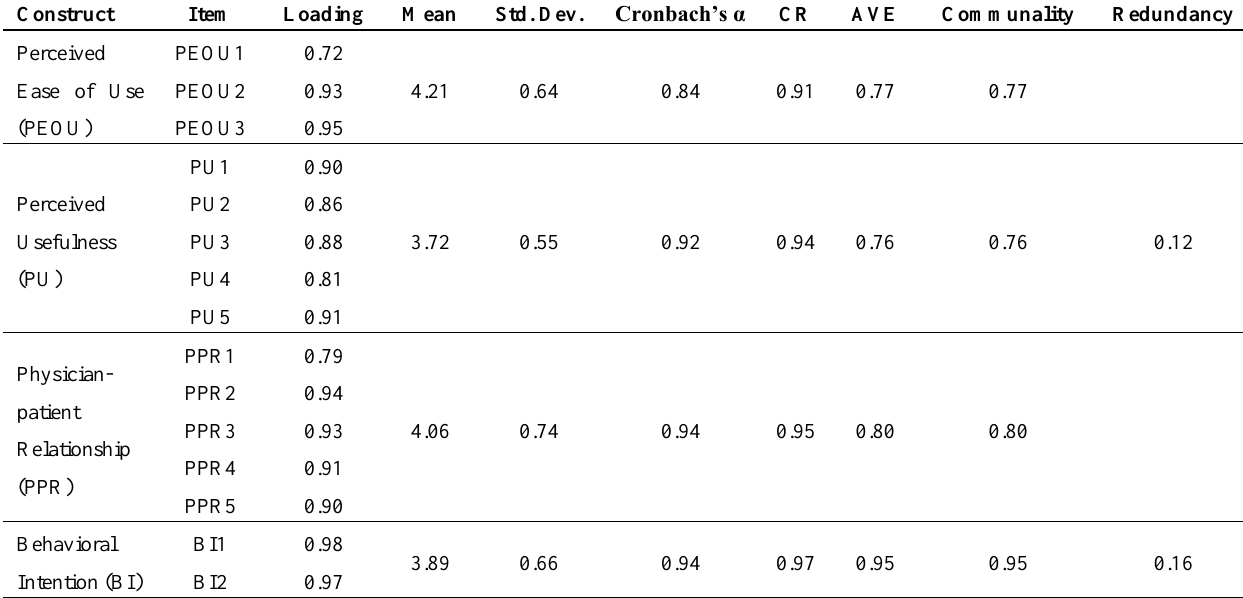
Table 1. Descriptive statistics of criteria for determining quality of